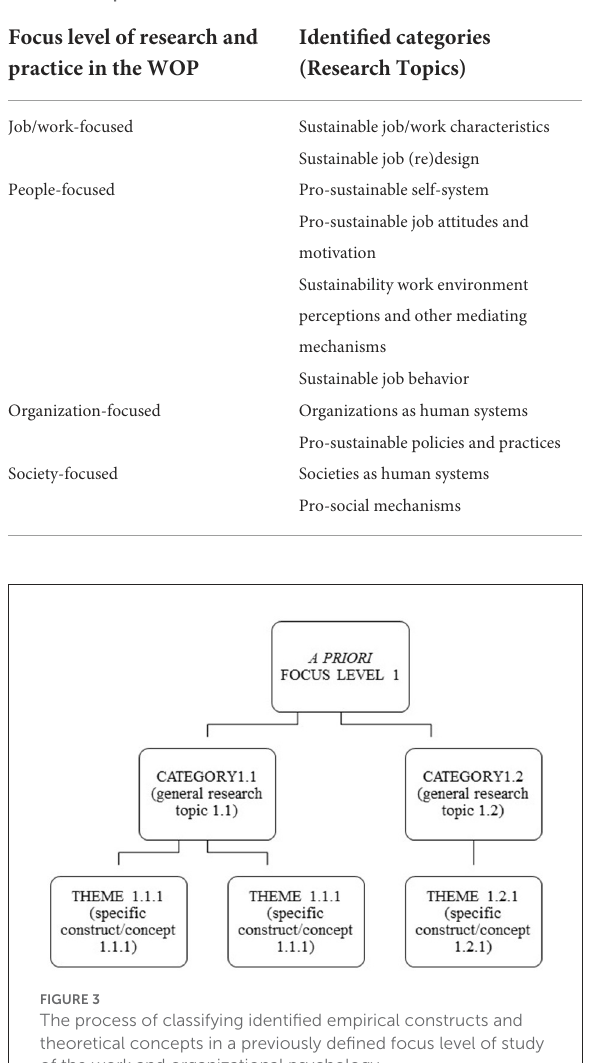
TABLE 1 A priori focus levels of the review and identified categories (Research Topics).